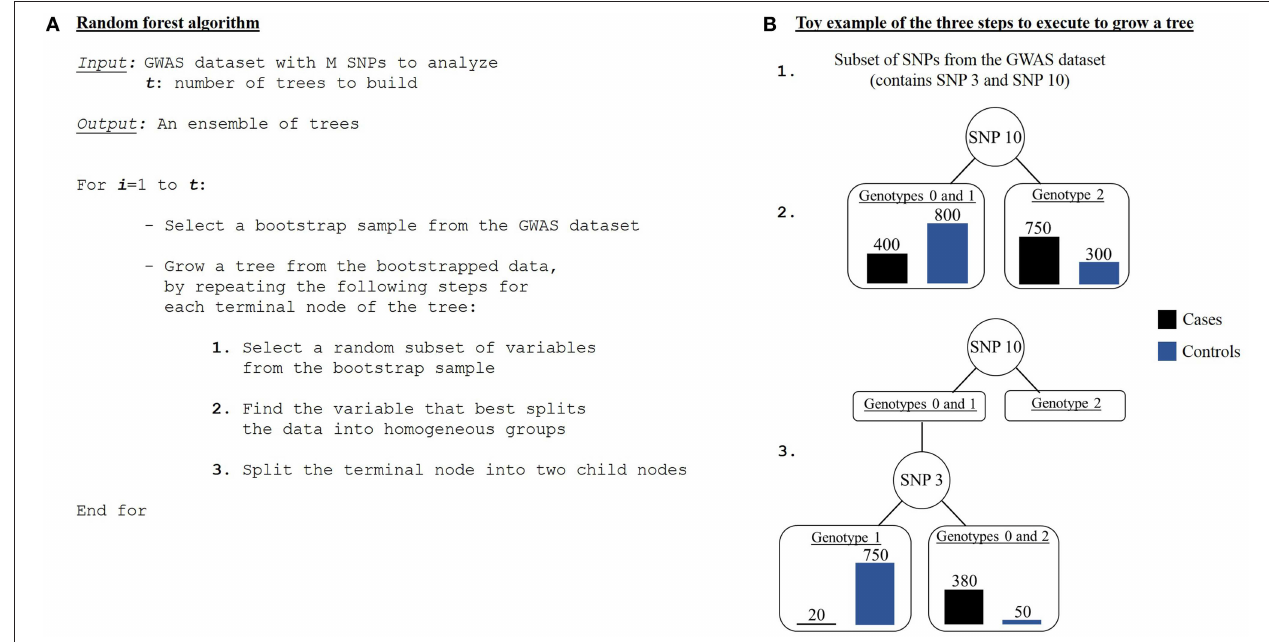
FIGURE 6 | Random forest algorithm. (A) Algorithm of a random forest procedure. (B) An example of the three steps needed to grow one